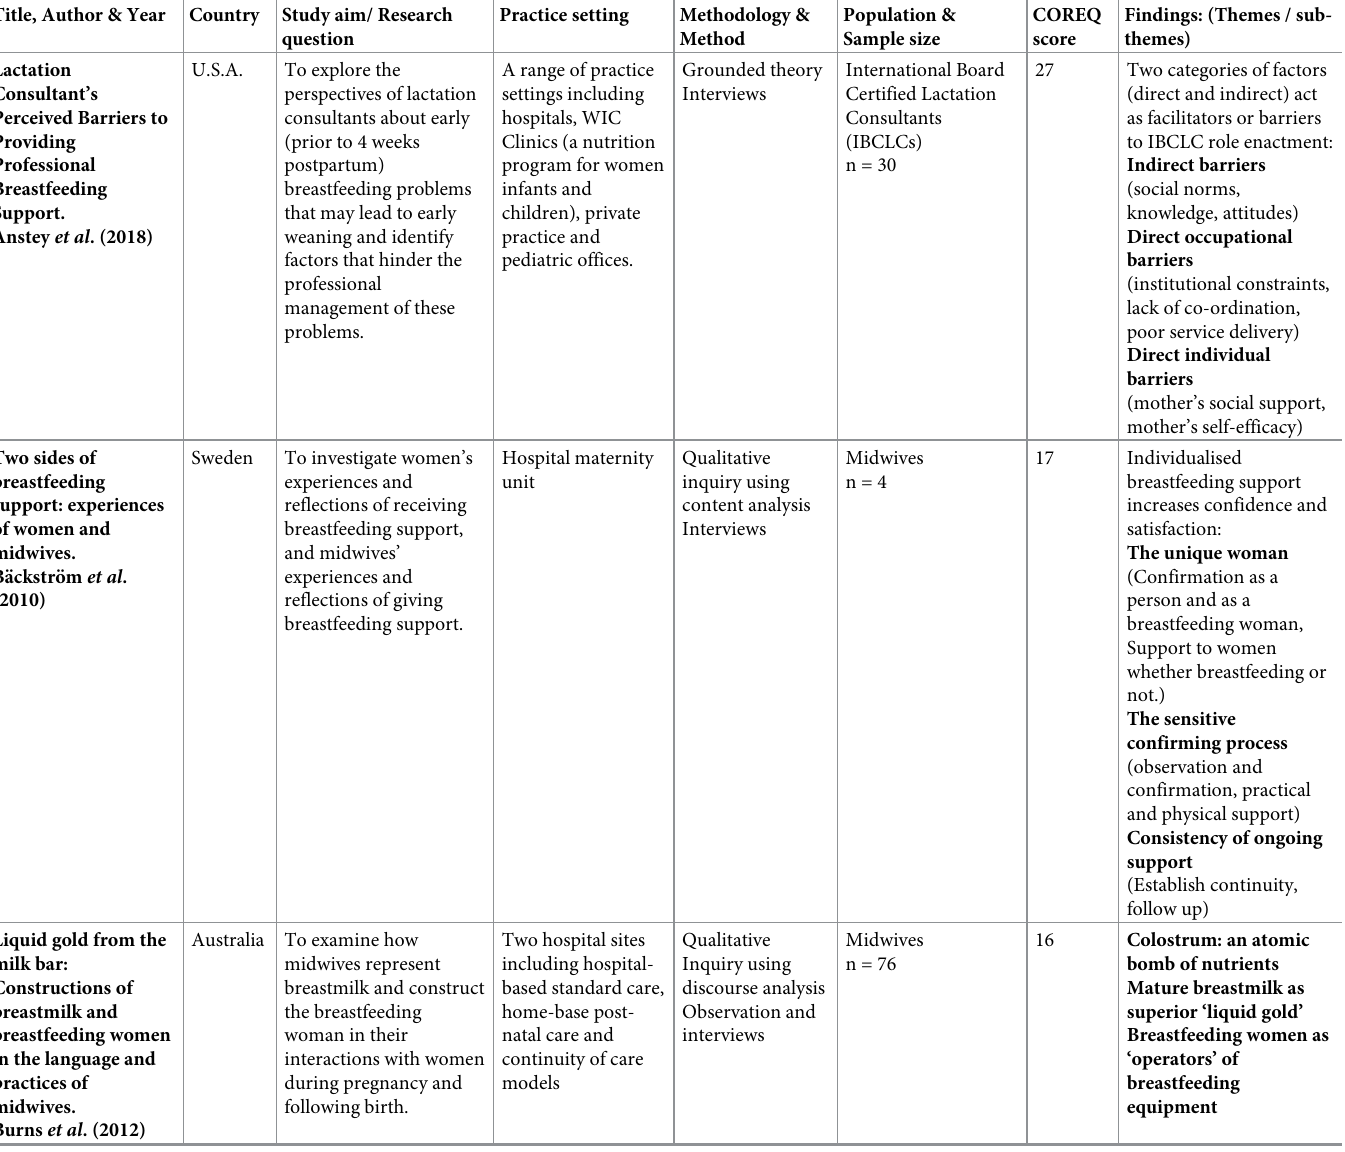
Table 1. Study characteristics and quality